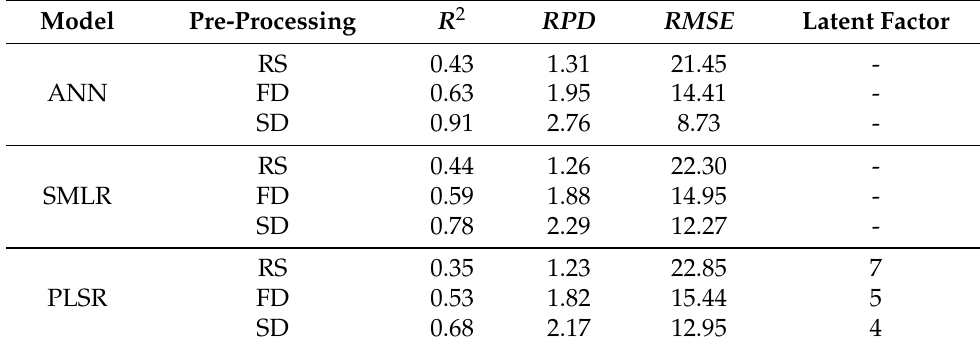
Table 4. Prediction results of Cr concentration using lab spectra and different data mining methods (validation data